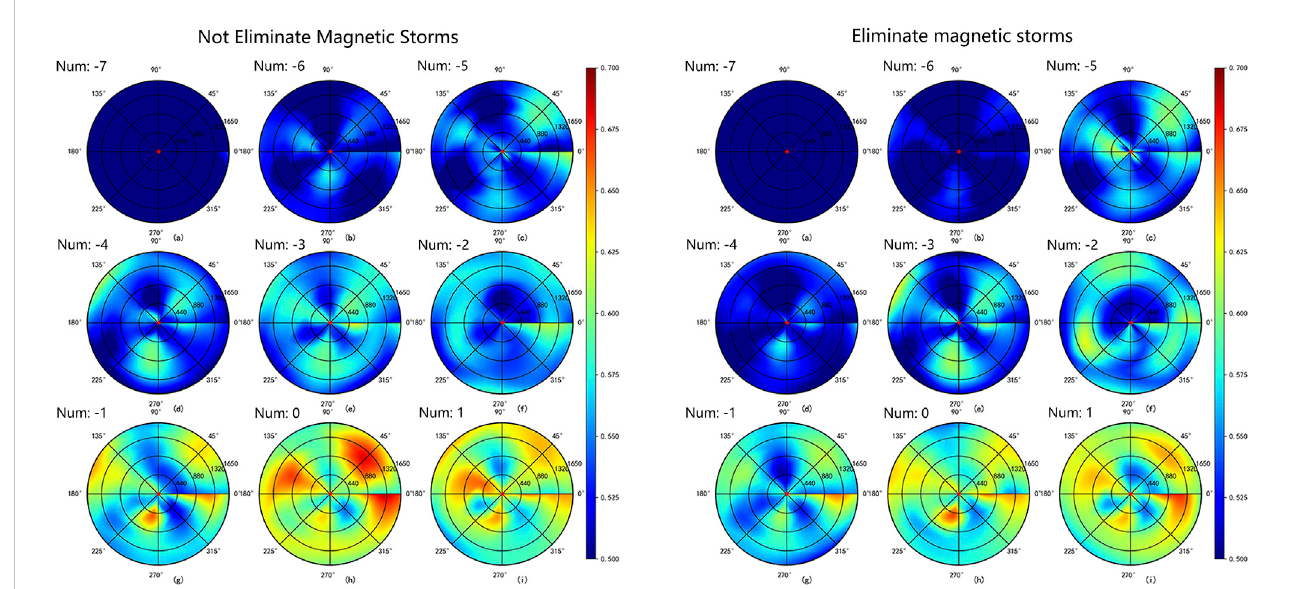
Spatial and temporal distribution of pre-seismic disturbances in the ELF frequency band (19.5 – 250 Hz) of the spatial electric fi eld after excluding the effects of magnetic storms for global magnitude 6.0 or higher earthquakes and without excluding the effects of magnetic storms. (Num: − 7 to Num: − 1 represents the seventh cycle to the fi rst cycle before the earthquake, Num: 0 is the period of earthquake, Num: 0 is the fi rst period after the